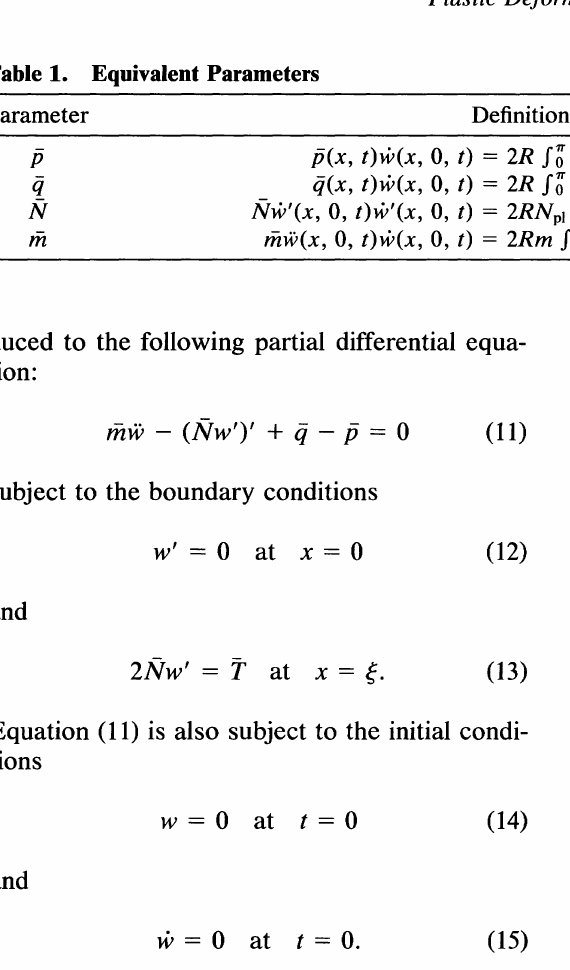
Table 1. Equivalent Parameters Parameter Definition Calculated